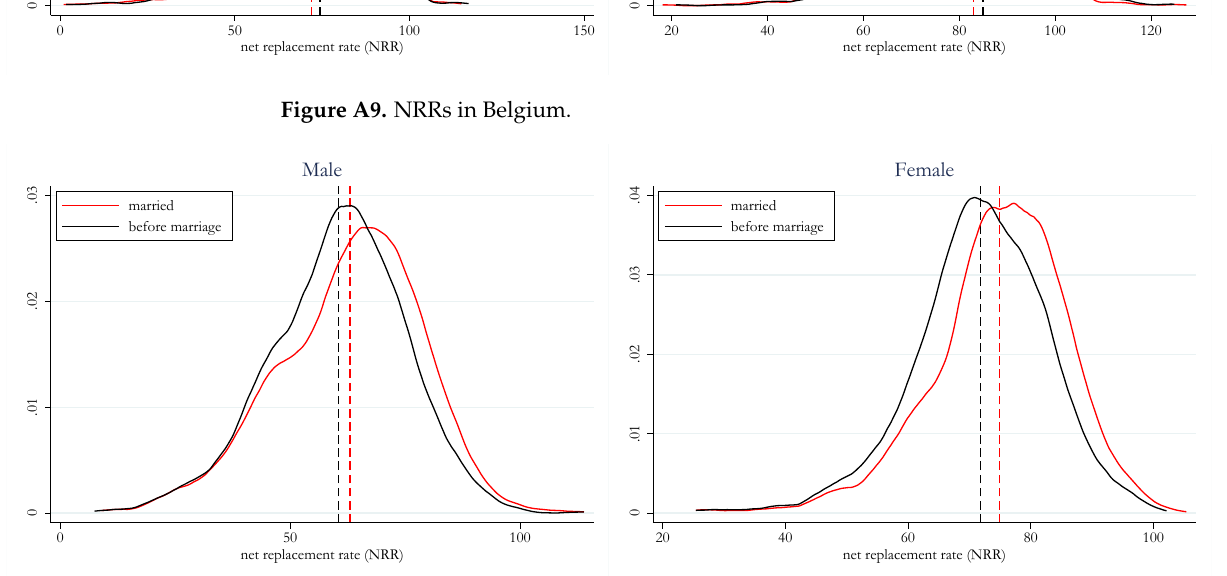
Figure A8. METRs in Poland.